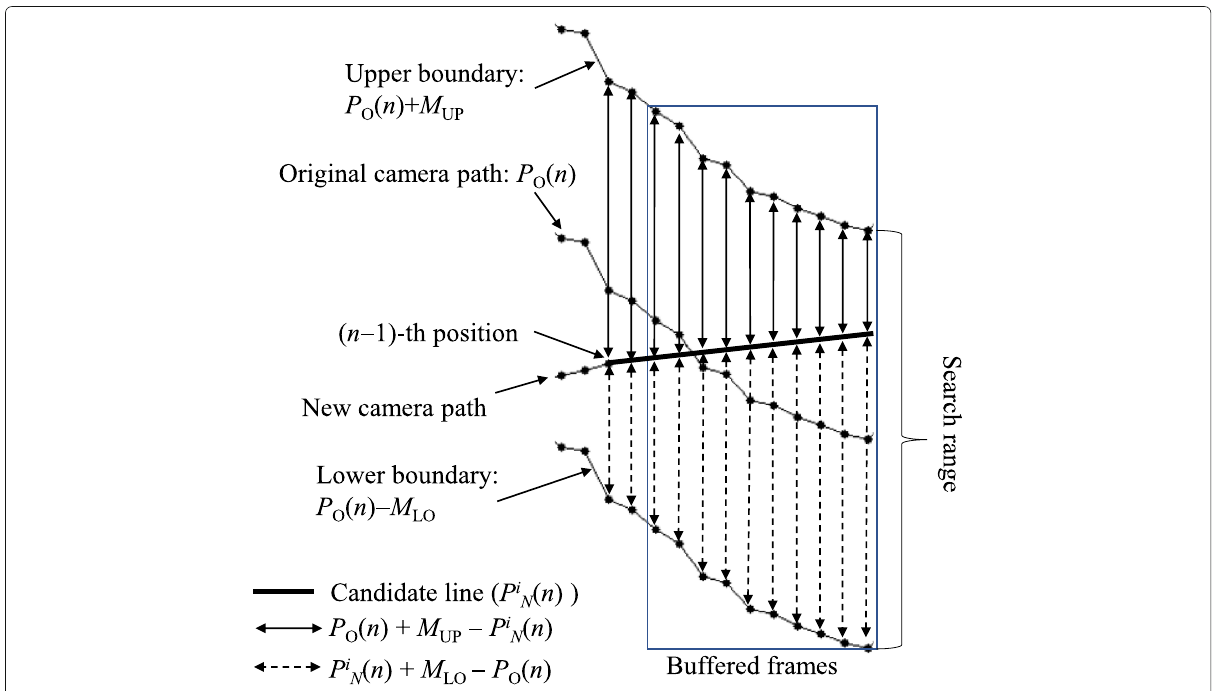
Fig. 8 Distance between the candidate line and boundaries